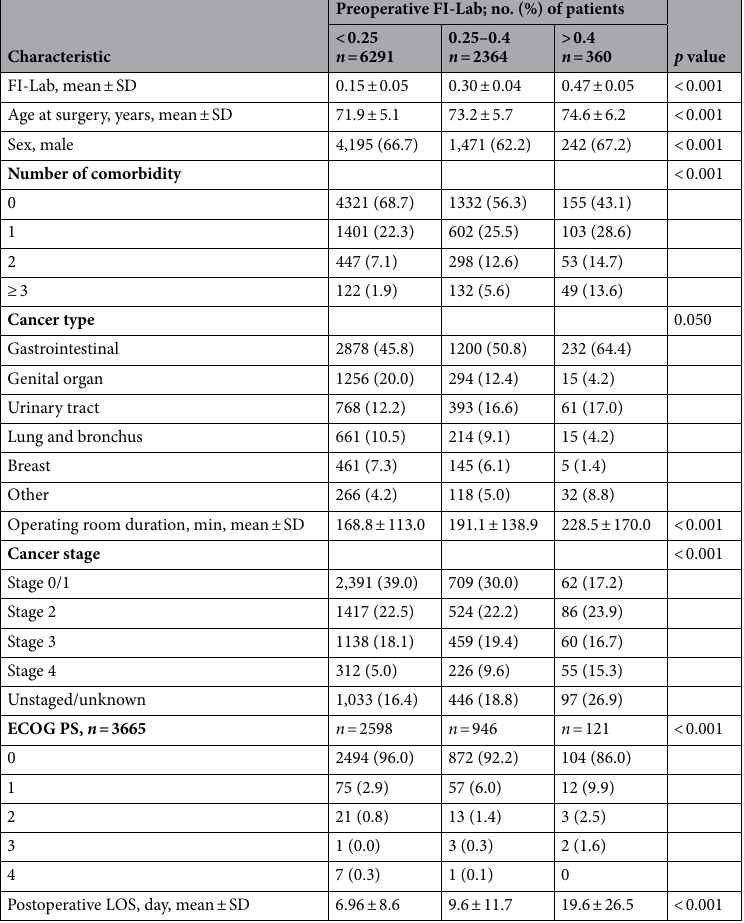
Table 1. Demographic and clinical characteristics of 9015 patients. ECOG PS eastern cooperative oncology group performance status, FI-Lab Frailty Index-Laboratory, LOS length of stay, SD standard deviation. Ohers indicated Head and neck cancer, hematologic malignancy, melanoma and bone